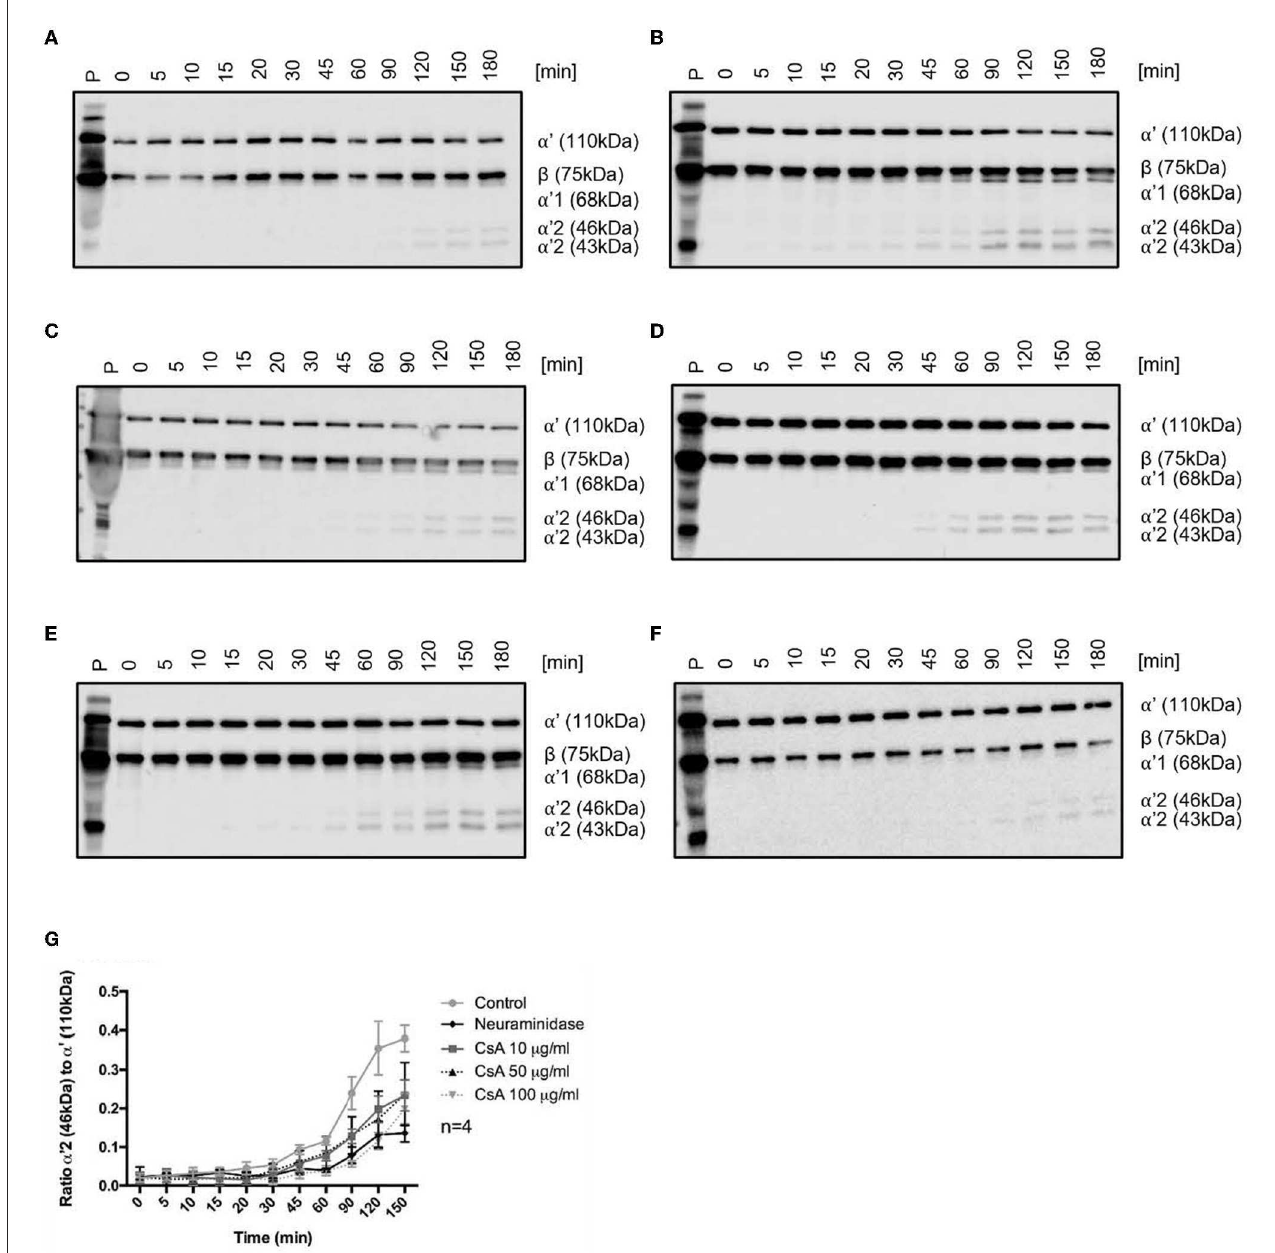
FIGURE5 Cyclosporine causes impaired complement factor H regulation on surfaces of endothelial cells. (A–F) Cyclosporine (CsA) leads to impaired complement factor H (CFH) surface cofactor activity detected by a CFH surface cofactor activity assay. Blood outgrowth endothelial cells (BOECs) were incubated with C3b 3.3 µ g/ml and complement factor I (CFI) 10 µ g/ml at 37 degrees Celsius, with or without pre-incubation with CFH 10 µ g/ml at 37 degrees Celsius. The appearance of C3b degradation fragments was analyzed by Western blotting (representative Western blots are shown in (A–F) . (A)